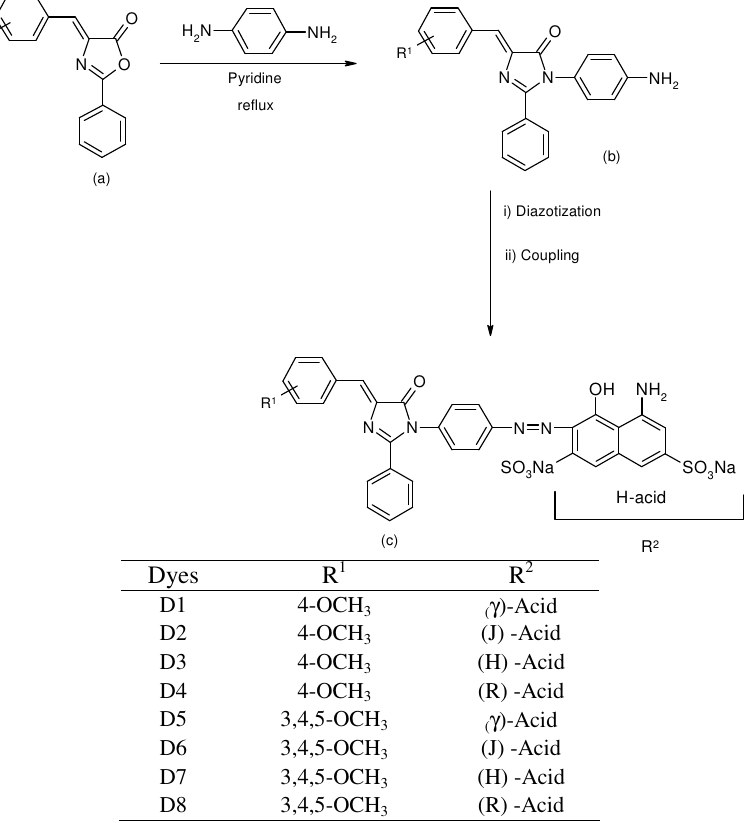
Scheme 1 . Synthesis of imidazolone based dyes D1 -